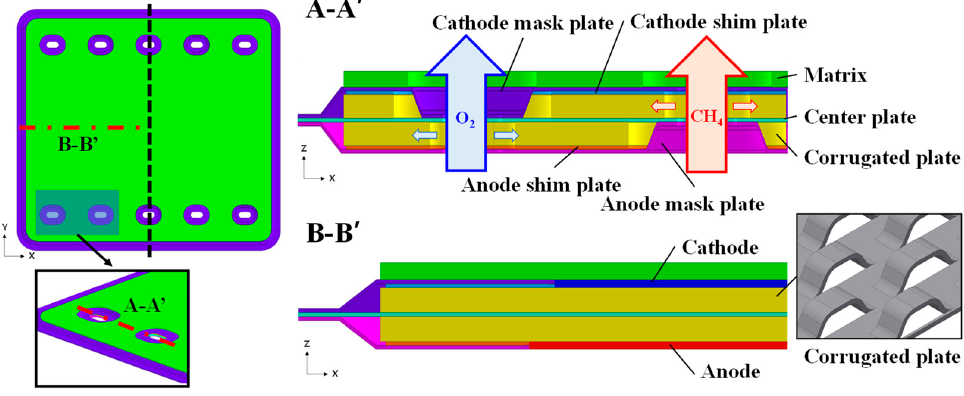
Figure 3. Schematic diagram of the internal manifold-type MCFCs.